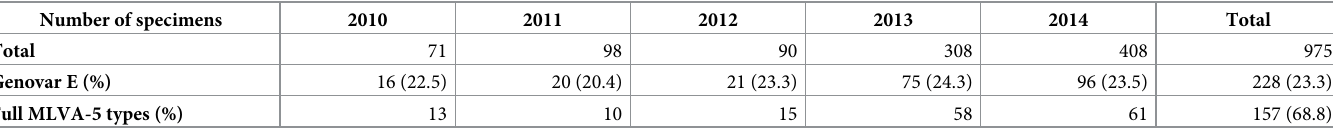
Table 1. French non-L anorectal specimens.